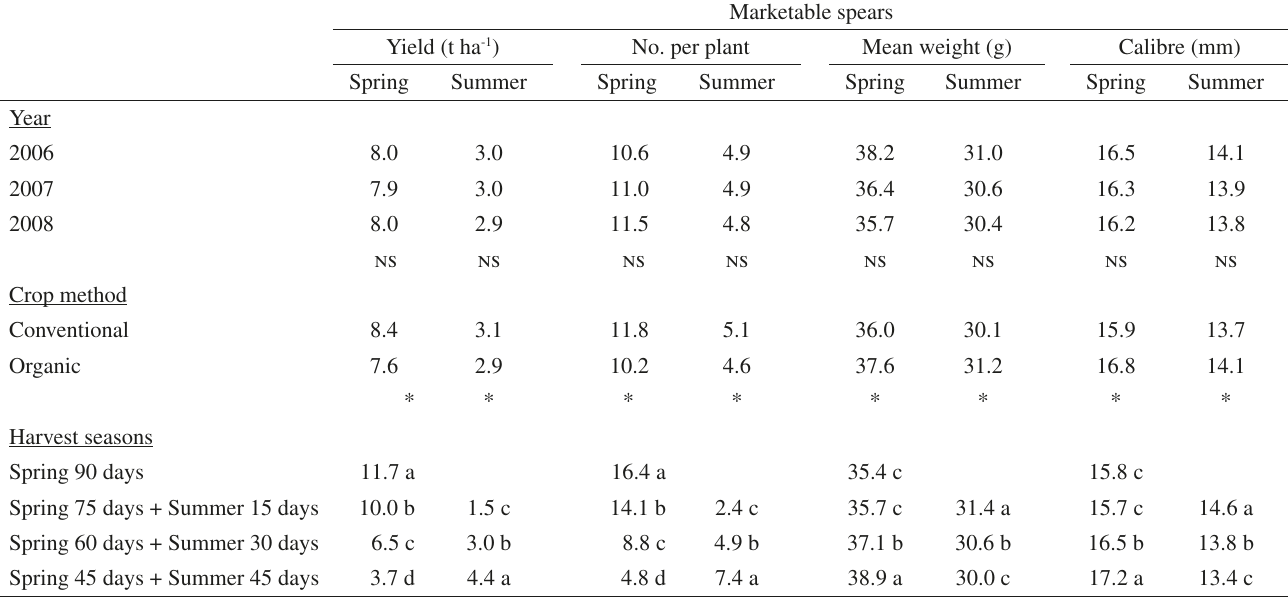
Table 3 - Asparagus spring and summer yield results as influenced by crop method and harvest